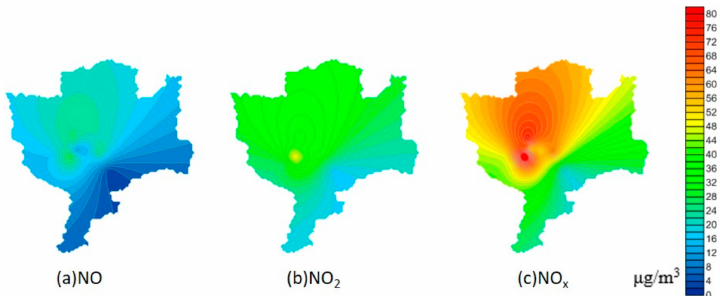
Figure 6. Spatial distribution of the average concentration of nitrogen compounds in Changchun, 2018: ( a ) NO, ( b ) NO 2 , ( c ) NO x